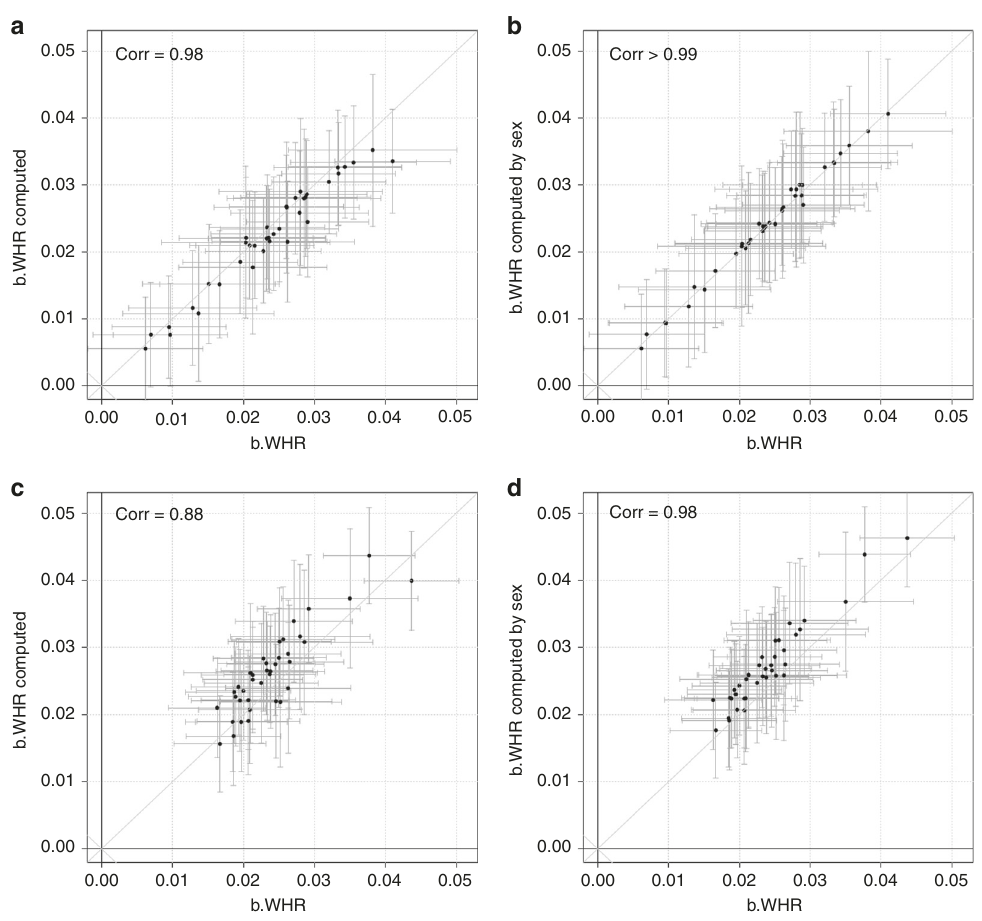
Fig. 3 Comparison of estimated and computed WHR effect sizes. The fi gure shows a comparison of effect sizes and standard errors for the 38 genome- wide signi fi cant WHR-derived lead variants. Using data from the UK Biobank (UKBB, N = 116,295) as a single large study, we compare estimated overall (sex-combined) WHR effects in UKBB data with a computed WHR effects that were calculated from overall BMI and WHRadjBMI effects in UKBB using the overall correlation between WHR and BMI ( r = 0.44, in UKBB); and with b WHR effects that were obtained from meta-analysis of computed sex- speci fi c WHR effects that were calculated from sex-speci fi c BMI and WHRadjBMI effects in UKBB using sex-speci fi c correlations ( r M = 0.60, r F = 0.46 in UKBB). Using GIANT meta-analysis summary statistics, we compare meta-analyzed overall WHR effects (resulting from meta-analysis of multiple studies) with c computed WHR effects that were calculated from meta-analyzed overall BMI and WHRadjBMI effects using the overall correlation between WHR and BMI ( r = 0.44, in UKBB), and with d WHR effects that were obtained from meta-analysis of computed sex-speci fi c WHR effects that were calculated from meta-analyzed sex-speci fi c BMI and WHRadjBMI effects using sex-speci fi c correlations ( r M = 0.60, r F = 0.46 in